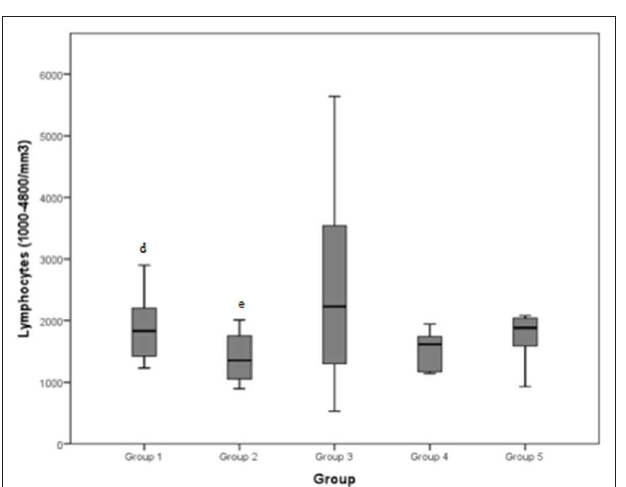
FIGURE 5 | Aspartate aminotransferase (AST) (normal range: 15–52 U/L) differences between the five examined groups. Statistically significant differences are indicated as follows: (a) significantly different from group 5; (b) significantly different from group 4; (c) significantly different from group 3; (d) significantly different from group 2; (e) significantly different from group